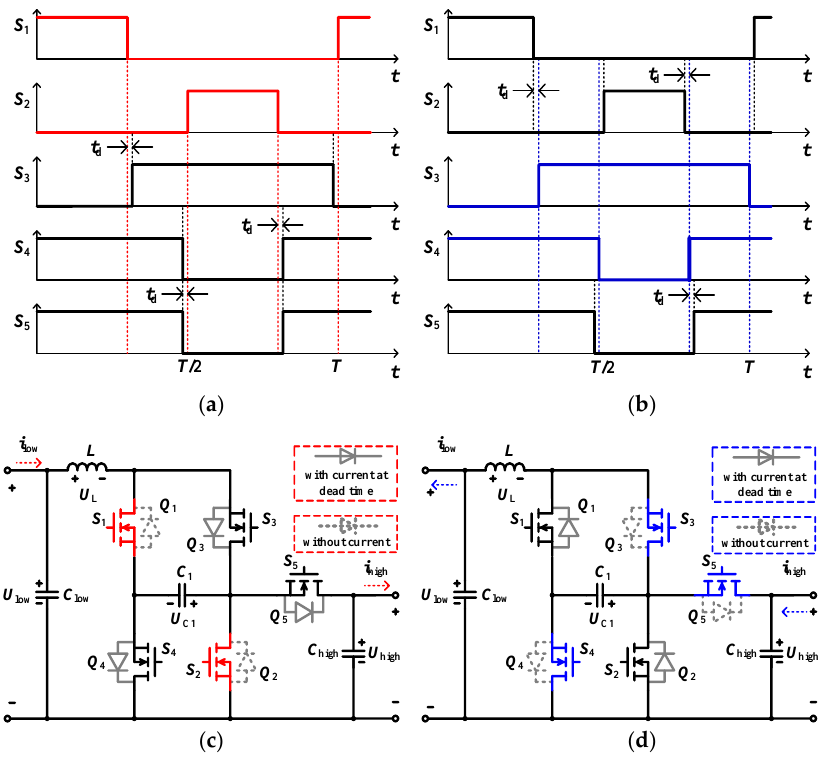
Figure 7. Synchronous rectification operation principle of the proposed converter; ( a ) Gate signals and dead time in step-up mode; ( b ) Gate signals and dead time in step-down mode; ( c ) Current flow path in step-up mode; ( d ) Current flow path in step-down mode.